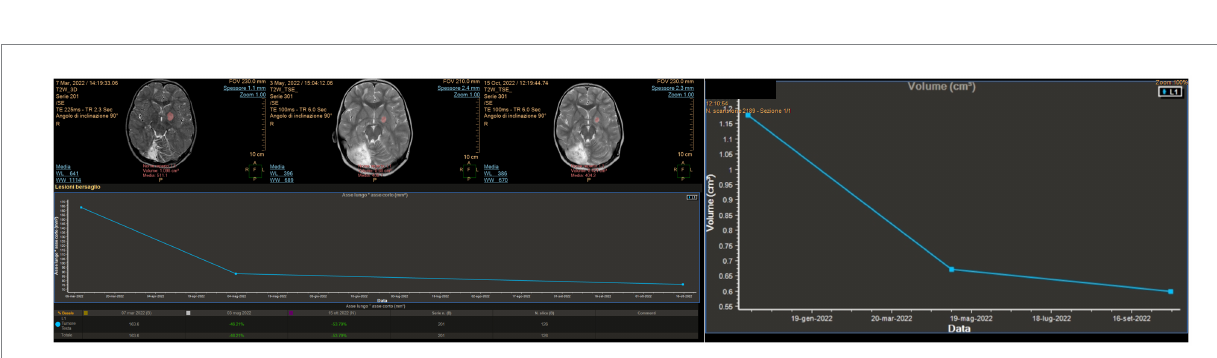
FIGURE 6 MITT Intellispace Portal imaging elaboration of magnetic resonance imaging shows a volumetric reduction of the known left thalamic tumor by more than 50% 7 months after surgery. The reduction of the proportion between the long and short axis is